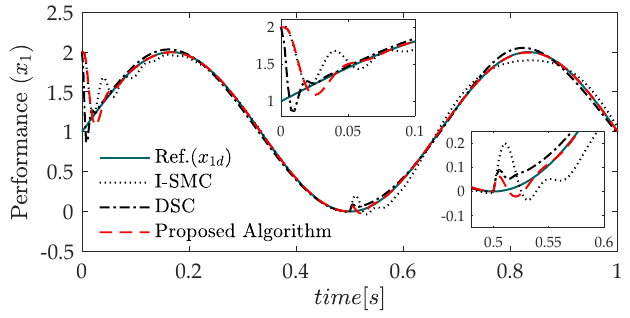
Figure 1. Tracking performance of 1 x .